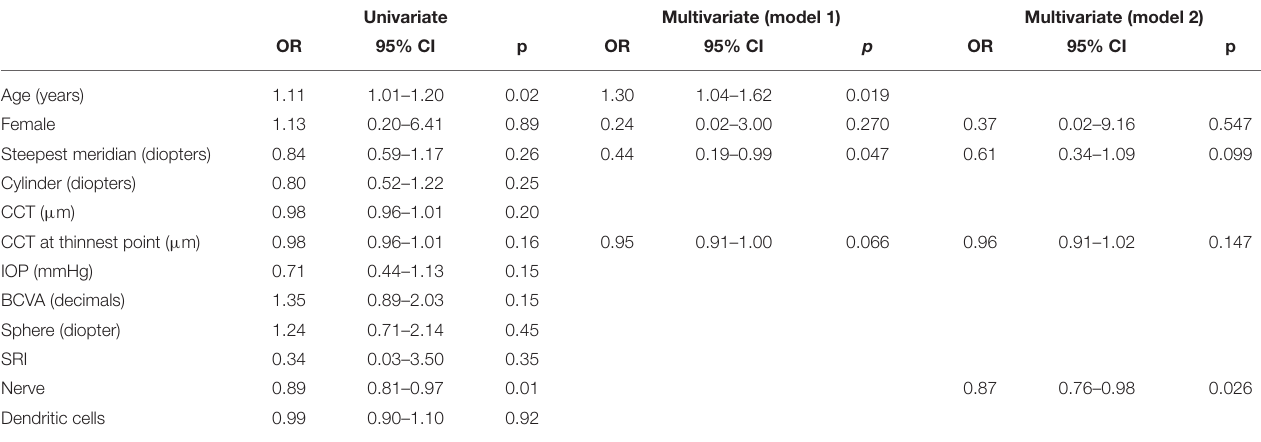
TABLE 2 | Analysis of the association between baseline demographic and anatomical parameters with